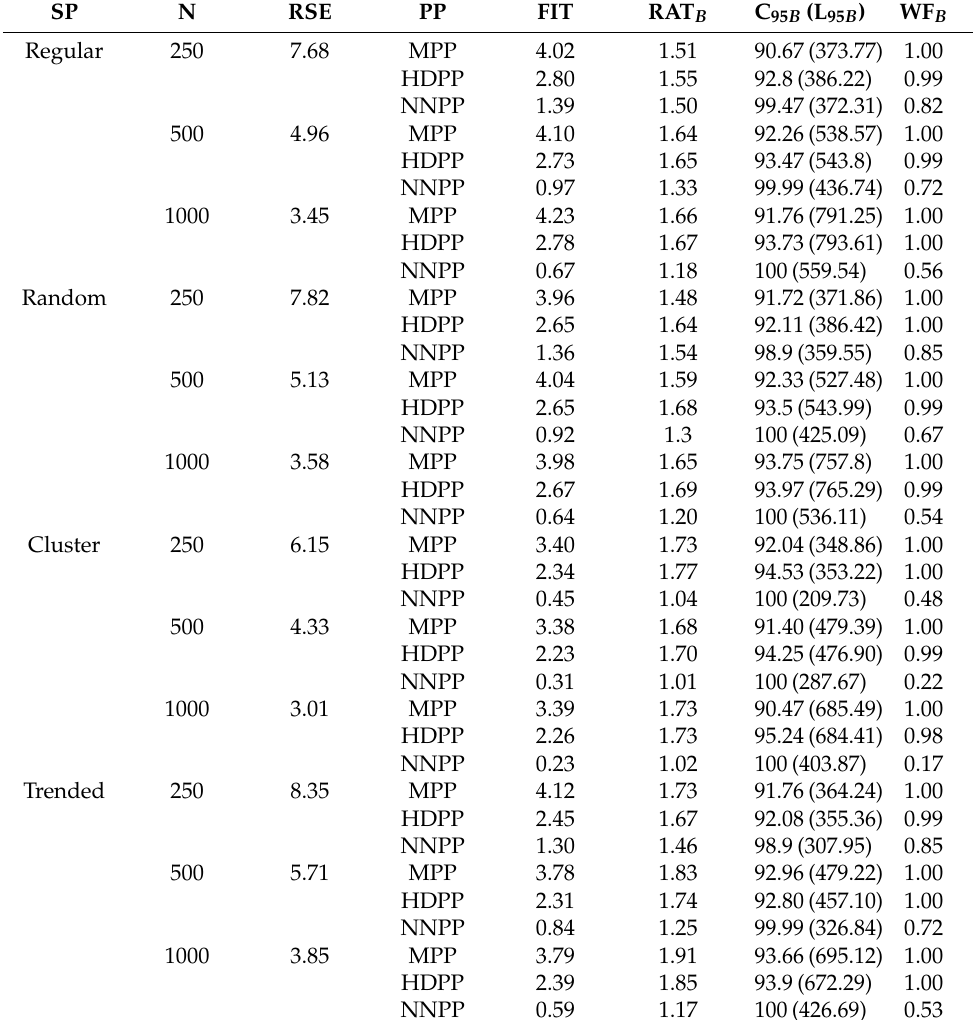
Table 1. Values of relative standard errors (RSE) of the Horvitz–Thompson estimator of totals, pseudo-population fitting indexes (FIT), ratios of expectations of bootstrap RSE estimators to the actual values (RAT B ), coverages of the 0.95 bootstrap confidence intervals (C 95 B ) and